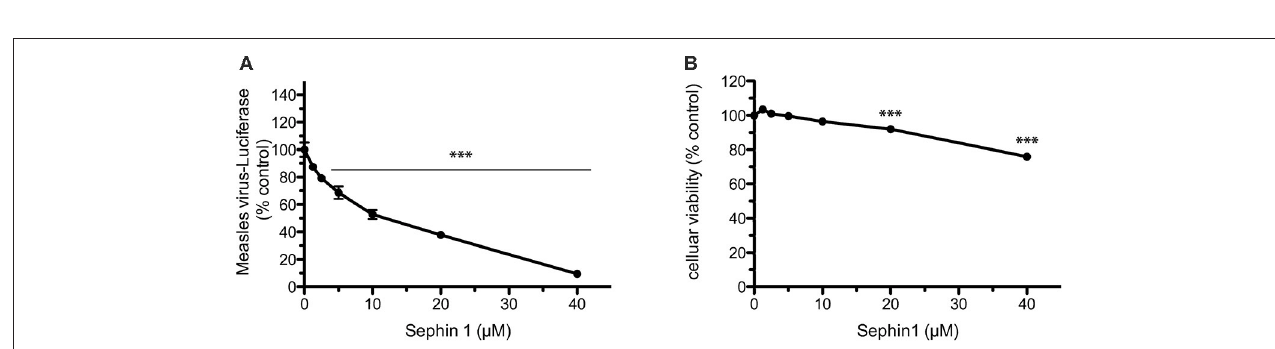
FIGURE 3 | Evaluation of the antiviral properties of Sephin1 against measles virus. (A) HEK293T cells were infected with a recombinant strain of measles virus expressing luciferase and incubated with increasing doses of Sephin1 or DMSO alone. After 24h, luciferase expression was determined. Data represent mean values from a representative experiment, repeated at least three times. (B) Viability of HEK293T cells incubated with increasing doses of Sephin1 or DMSO alone was determined after 24h incubation using the cellular viability assay Vita-Blue. Data represent mean ± SEM from representative experiments, repeated at least three times. *** p < 0.001 by one-way analysis of variance, followed by Bonferroni comparison test comparing the Sephin1-treated groups at the indicated concentrations to the vehicle-treated control